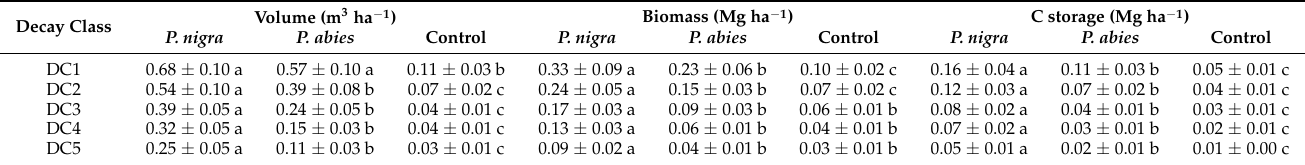
Table 8. Volume, biomass, and C storage of deadwood (DW) at the study